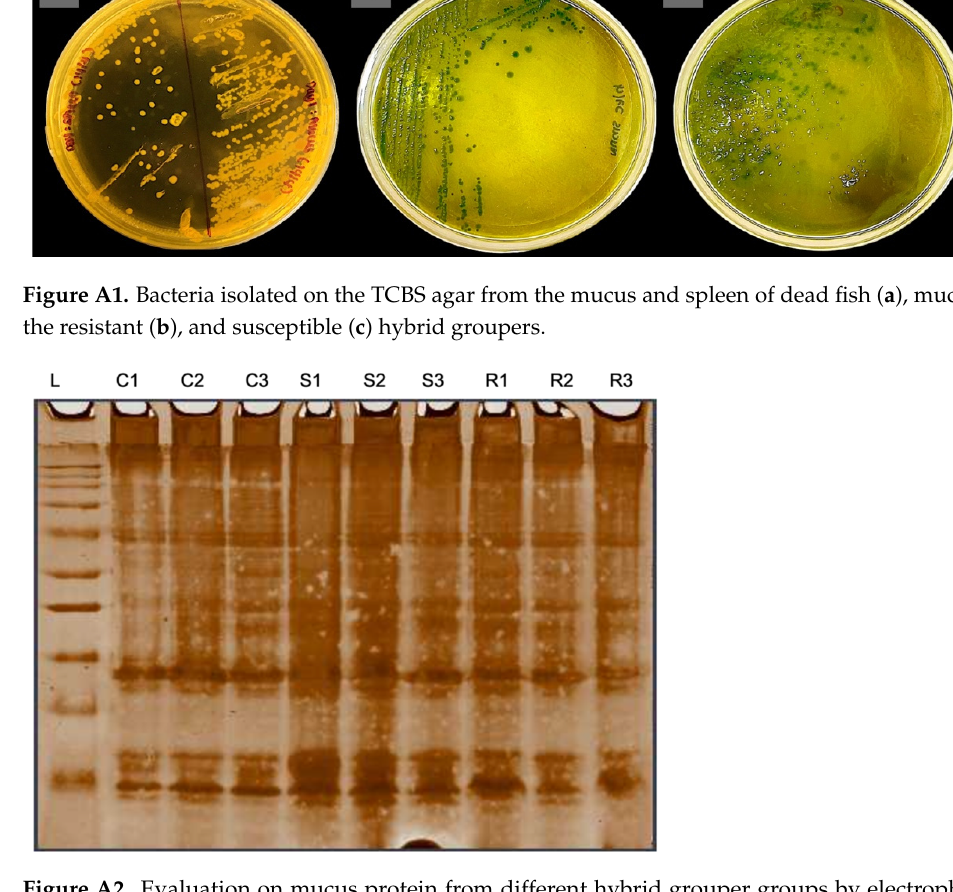
Figure A2. Evaluation on mucus protein from different hybrid grouper groups by electrophoretically separated on 12% SDS polyacrylamide gel and double stained with Coomassie-silver. C1,C2,C3—control, S1,S2,S3—susceptible, and R1,R2,R3—resistant. Table A1. Differentially expressed protein-enriched in KEGG pathways.